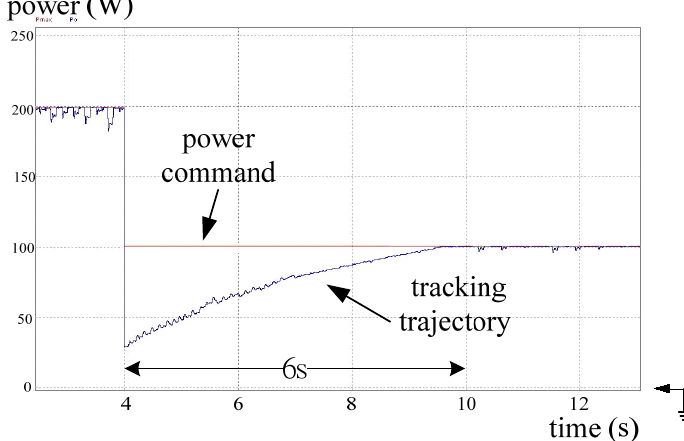
Figure 20. Simulated result: tracking trajectory of the converter with the POM while PV power steps down from 200 to 100 W. Note: power: 50 W/div; time: 2 s/div.